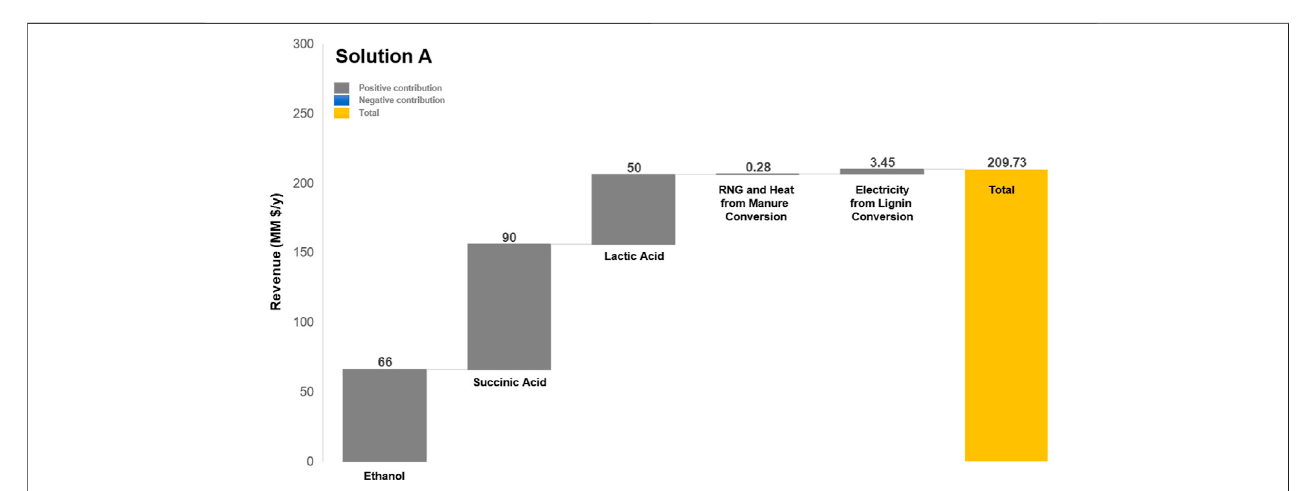
FIGURE 11 | Solution A: contribution of the main products to the biore fi nery ’ s